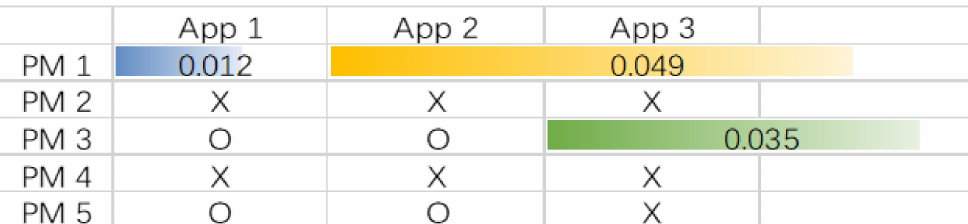
Figure 12. Specific state of the physical machines. where “